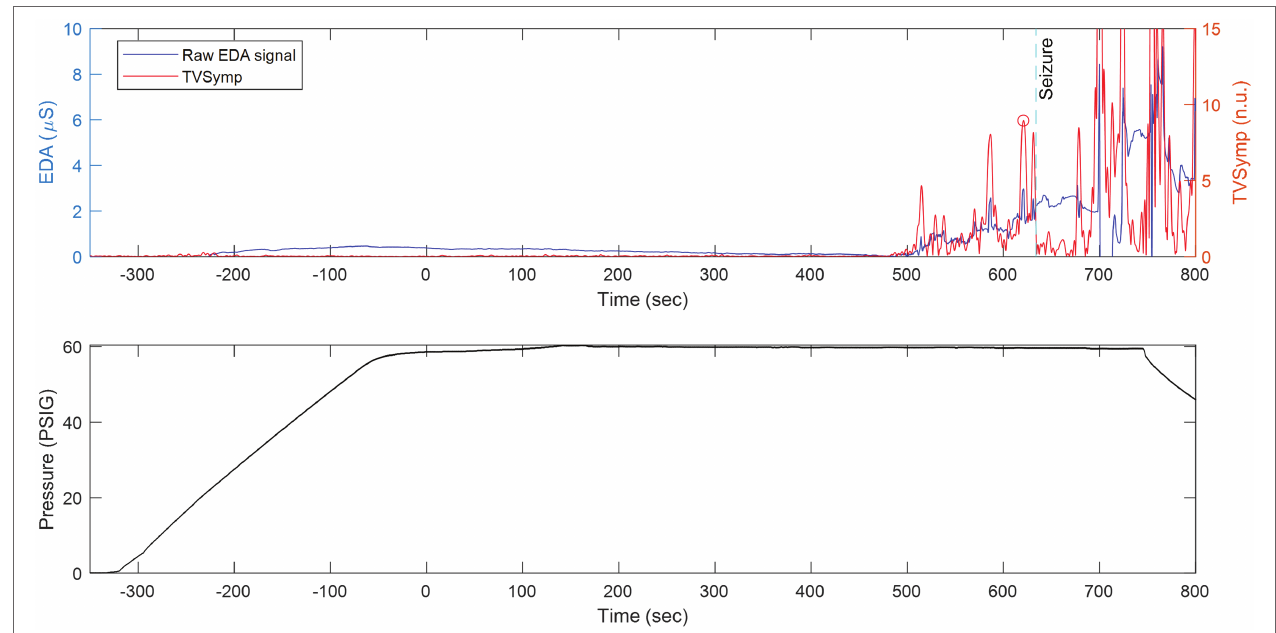
FIGURE 5 | The same animal as in Figure 8 but with the x-axis compressed in time to show continuously measured raw EDA and its derived TVSymp activity before, during, and after seizure. Top: Raw EDA and time-varying spectral analysis of EDA (TVSymp, non-dimensional units) for a rat undergoing exposure to 5 ATA of HBO 2 . Bottom: Profile of the